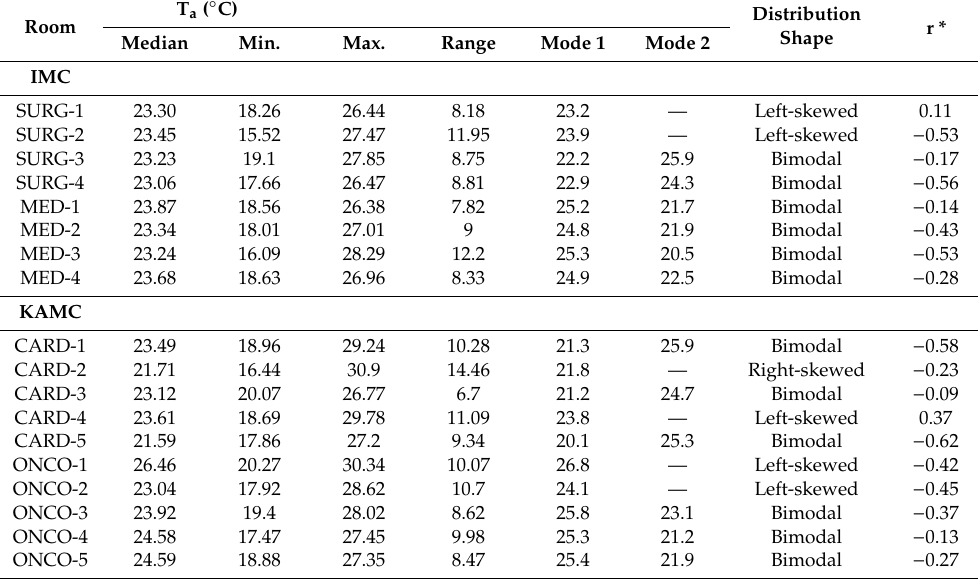
Table 5. Descriptive summary statistics of T a in patient rooms in IMC and KAMC.